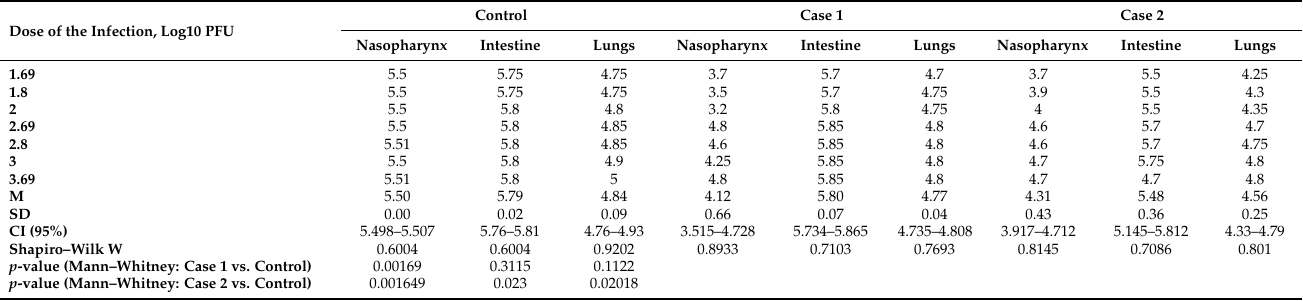
Table 3. The viral peak load and day post-infection during the suppression of virus accumulation in the nasopharynx only (Case 1) and in both compartments (Case